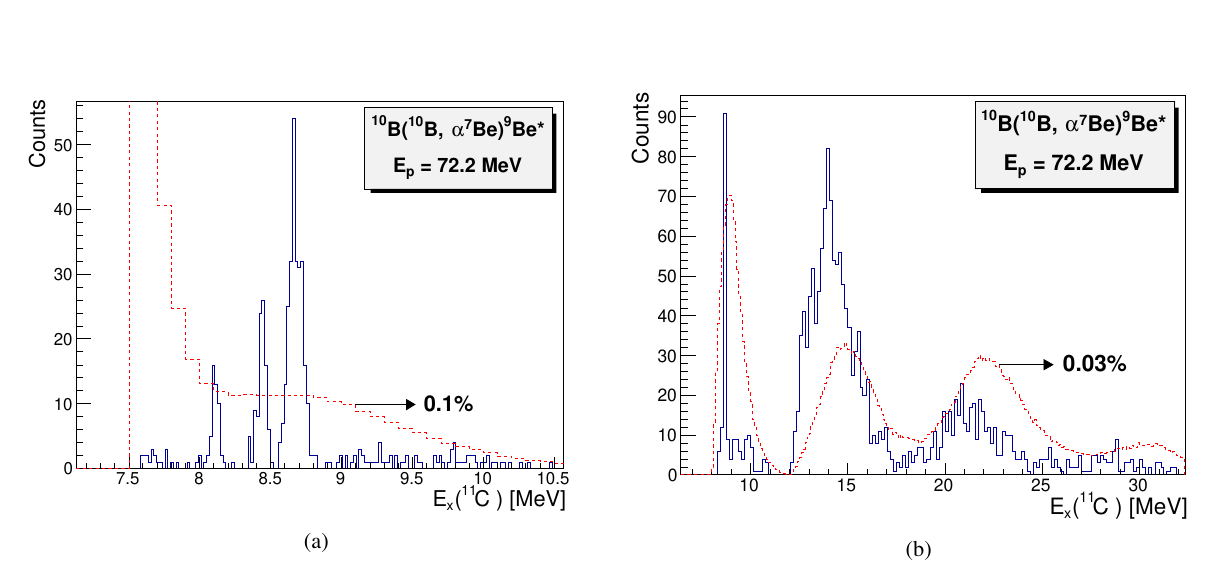
Figure 3: The 11 C excitation energy spectra obtained from measured 7 Be and α -particle coincidences: (a) in detectors that lie on the same side of the beam (events in which both particles are detected in the same detector are included); (b) in all detector combinations, except the ones where both particles are detected in same detector. The (red) dotted lines show the corresponding Monte Carlo e ffi ciency